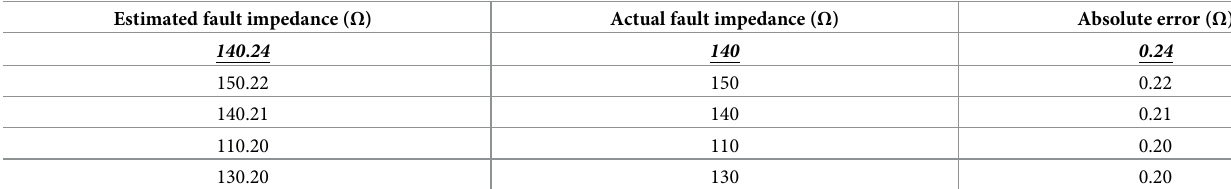
Table 13. Fault impedance estimation (CGF).